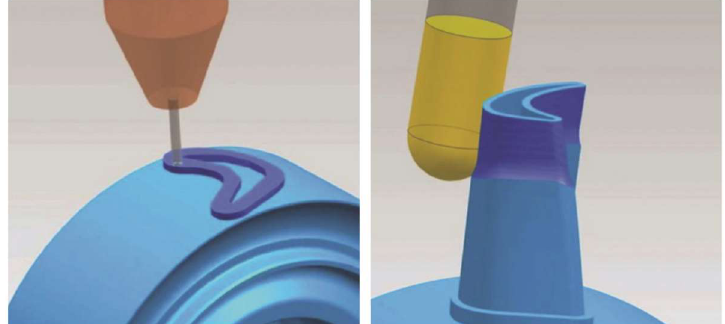
Figure 11. In-process workpiece and verification work for both additive and subtractive modes, by Siemens PLM Software [161], used under CC BY-ND 2.0.